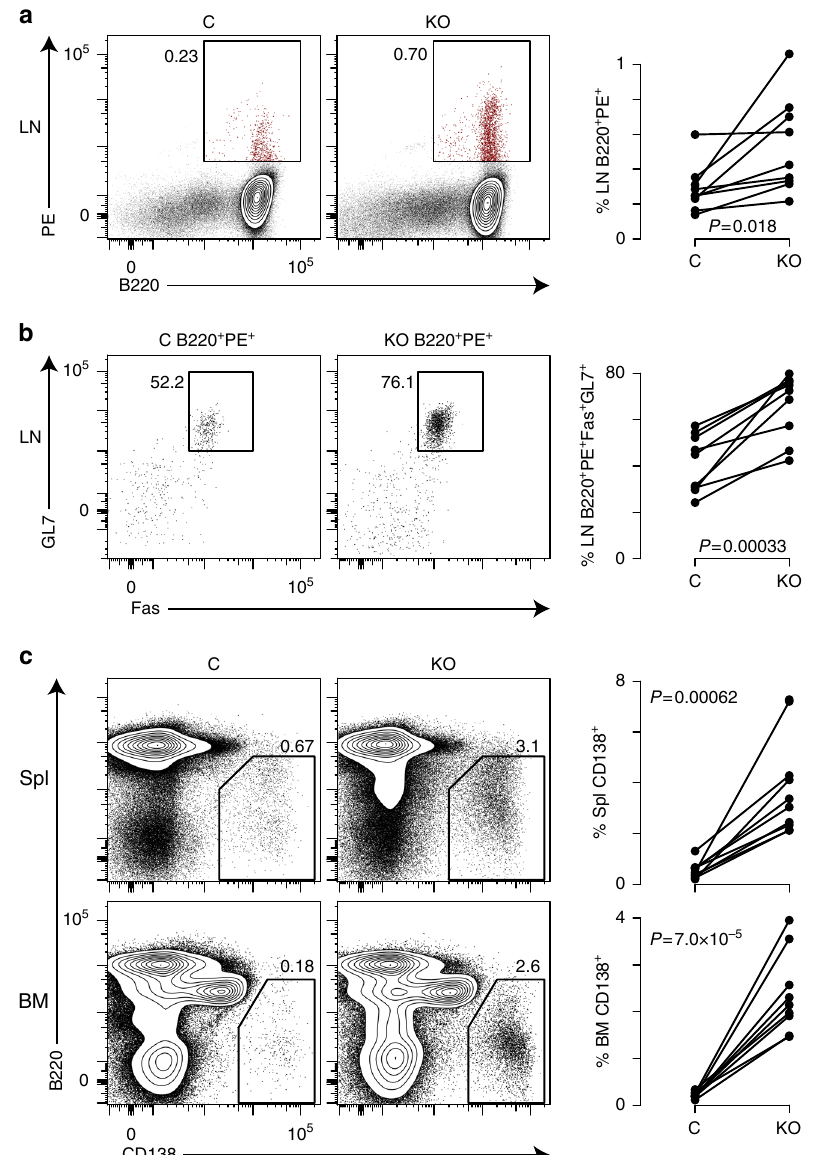
Fig. 2 Cell autonomous control of B cell proliferation and differentiation. a B220 expression and PE binding of control (C) (CD45.1 + CD45.2 + Dnmt3a fl / + Dnmt3b fl / + ) and KO (CD45.2 + Cd19 cre/ + Dnmt3a fl / fl Dnmt3b fl / fl ) cells in the inguinal and periaortic lymph nodes (LN) 30 days after PE-CFA challenge. b Fas and GL7 expression on B220 + PE + LN cells in a . c CD138 and B220 expression on C and KO cells in the spleen (Spl; top) and bone marrow (BM; bottom) of chimeric mice. All data are lymphocyte size gated and CD11b − CD11c − F4/80 − Thy1.2 − . P values are calculated using a paired t -test. Data represent two experiments with four and fi ve mice per experiment with four male and fi ve female